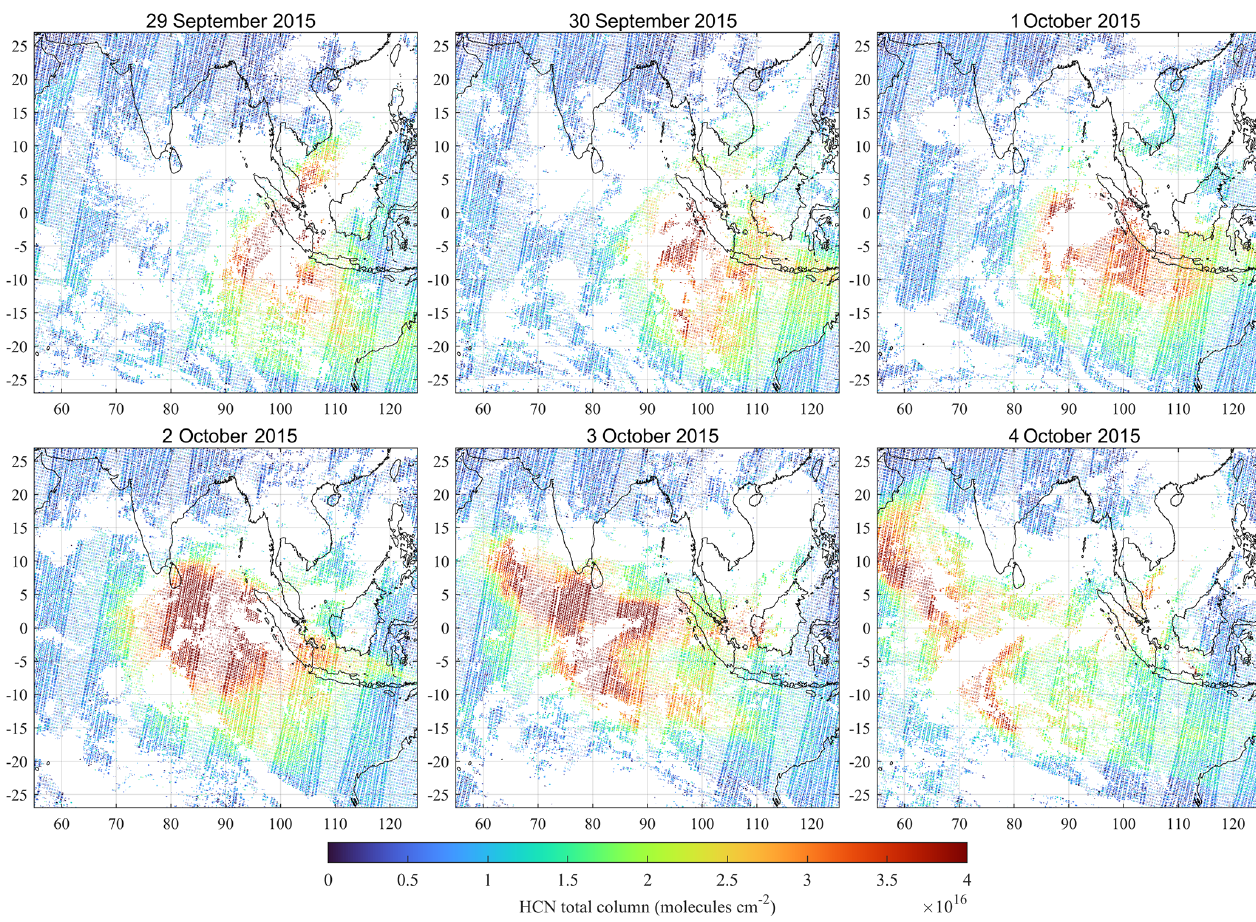
Figure A1. Daily regional distributions of HCN total column (in moleculescm − 2 ) derived from the IASI spectra recorded in the morning overpasses of Metop-A and B, for 6 successive days during the 2015 Indonesian fires. These distributions take into account the actual footprint on the Earth’s surface of each individual IASI measurement, i.e. a small circle at nadir and an elongated ellipse at the limit of the across-track swath of the satellite. Note the complementarity of the IASI/Metop-A and B flight tracks that avoid gaps between the successive overpasses in the tropics. The white areas correspond to data filtered out because of unsatisfactory retrieval quality or the presence of